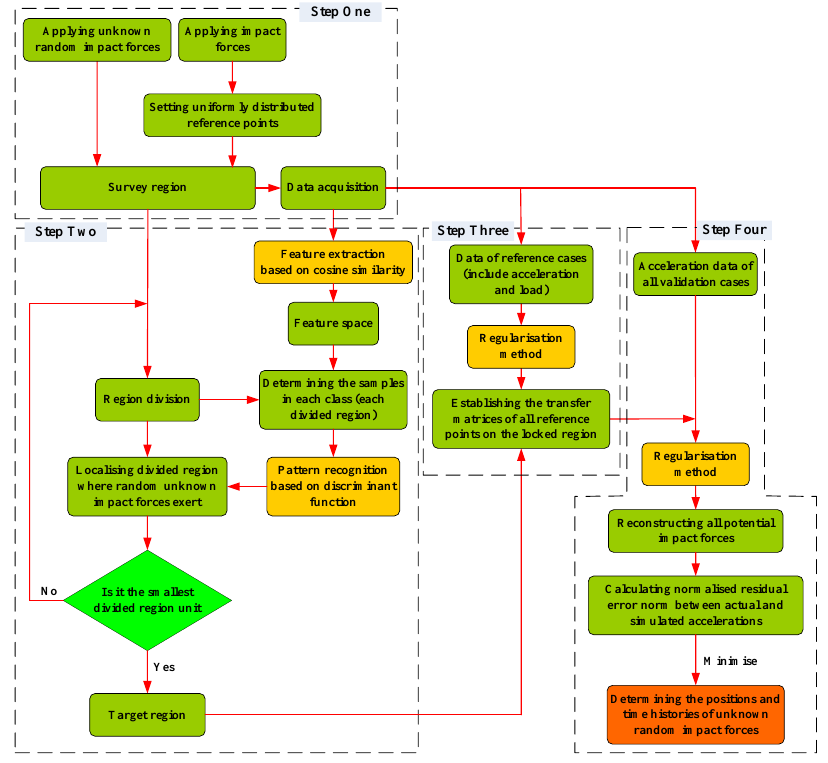
Figure 1. The process for random impact force identification based on a hybrid algorithm.